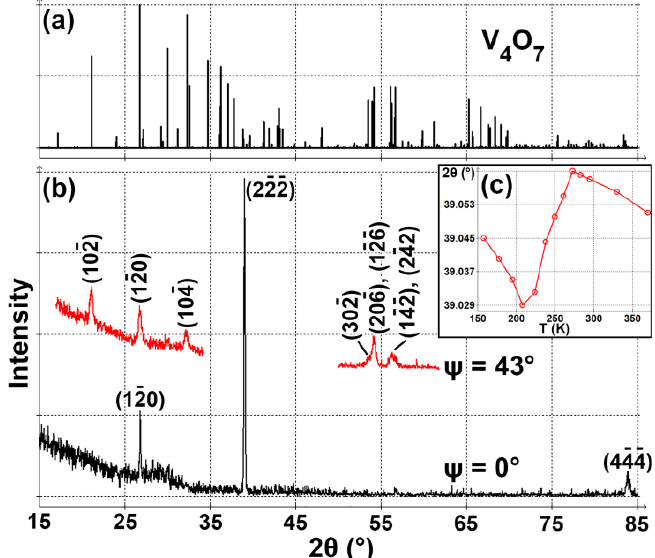
Figure 1. ( a ) Calculated XRD powder pattern of V 4 O 7 . ( b ) XRD patterns of a V 4 O 7 film measured at different sample tilts ( ψ ). ( c ) Dependence of ( 222 ) peak position on temperature.